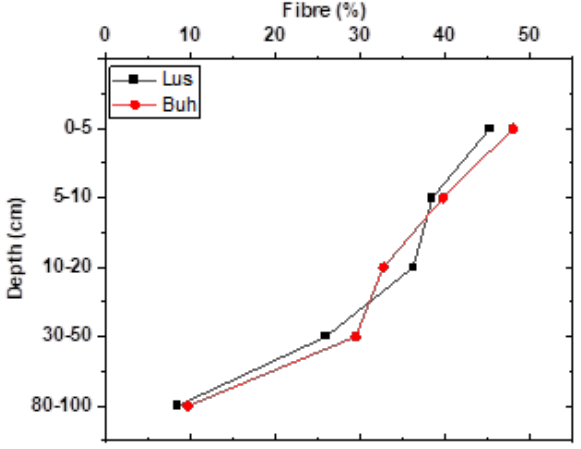
Figure 3. Fibre content determined on peat collected from depths of 0–5, 5–10, 10–20, 30–50 and 80–100 cm at Buhandanda (Buh) and Lushala